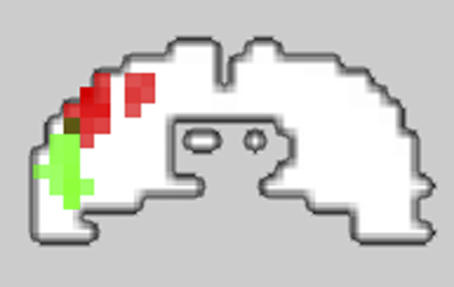
Regions of the dorsolateral prefrontal cortex found to exhibit significant connectivity with face-sensitive (red) and place-sensitive (green) visual regions during the formation of new associations between faces and places.